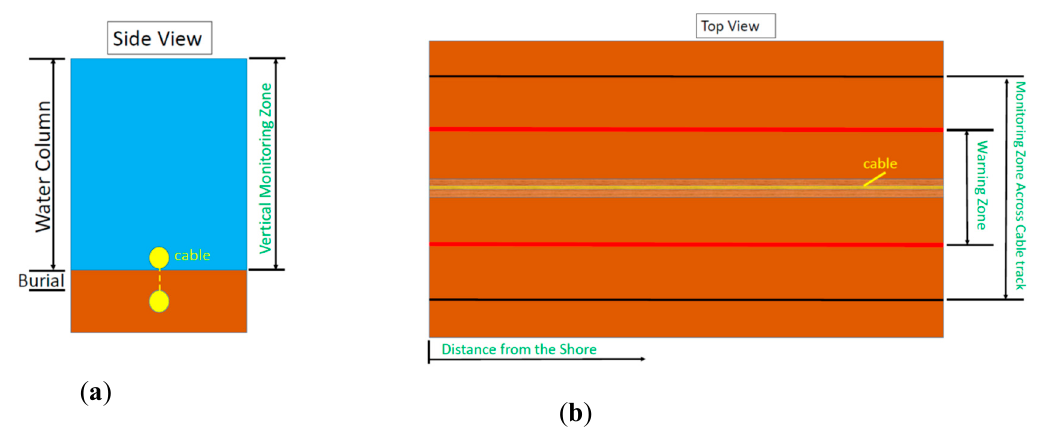
Figure 7. Monitoring areas of underwater cables. ( a ) Vertical monitoring zone, ( b ) horizontal monitoring zones: across cable track and warning zone. Table 23. Multi-threat sabotage scenario